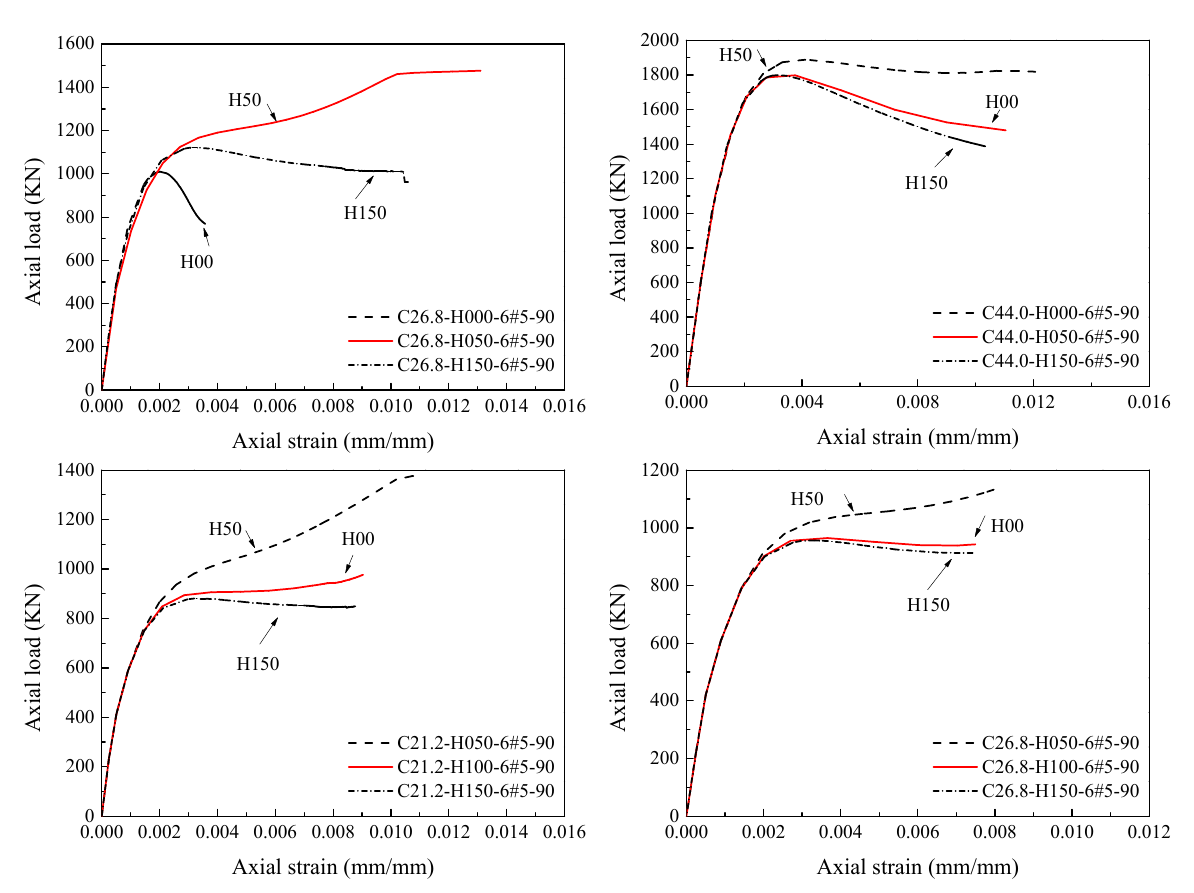
Figure 21. Effect of varying confinement ratios of GFRP spirals on the load-strain response of HCCs.